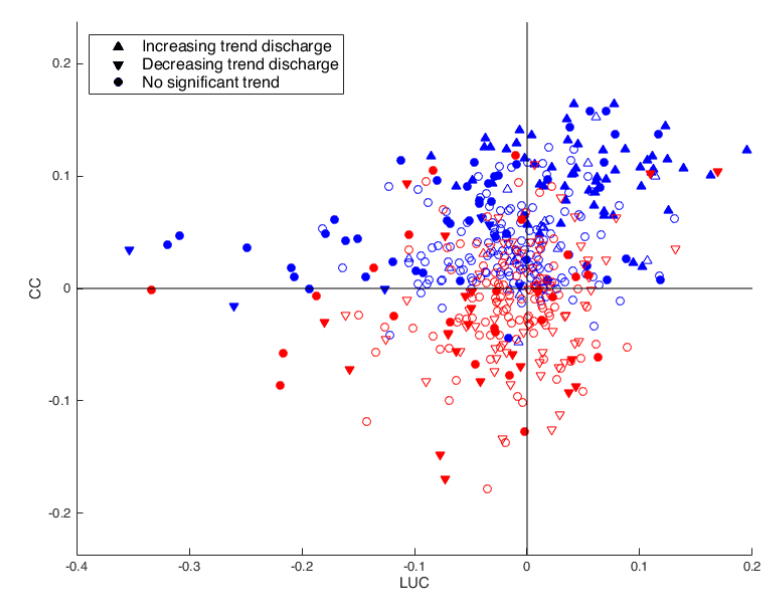
Figure 3. Contribution of land use change ( x -axis) and climate change ( y -axis) for the American (blue) and Australian (red) catchments. Filled symbols indicate a significant value of ( LUC ) and/or climate change ( CC ) and open symbols indicate a non-significant value.